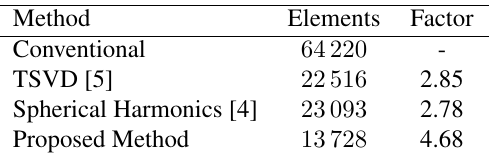
Table 2: Number of elements for the aggregation matrices associated with the example structure in Fig. 1.